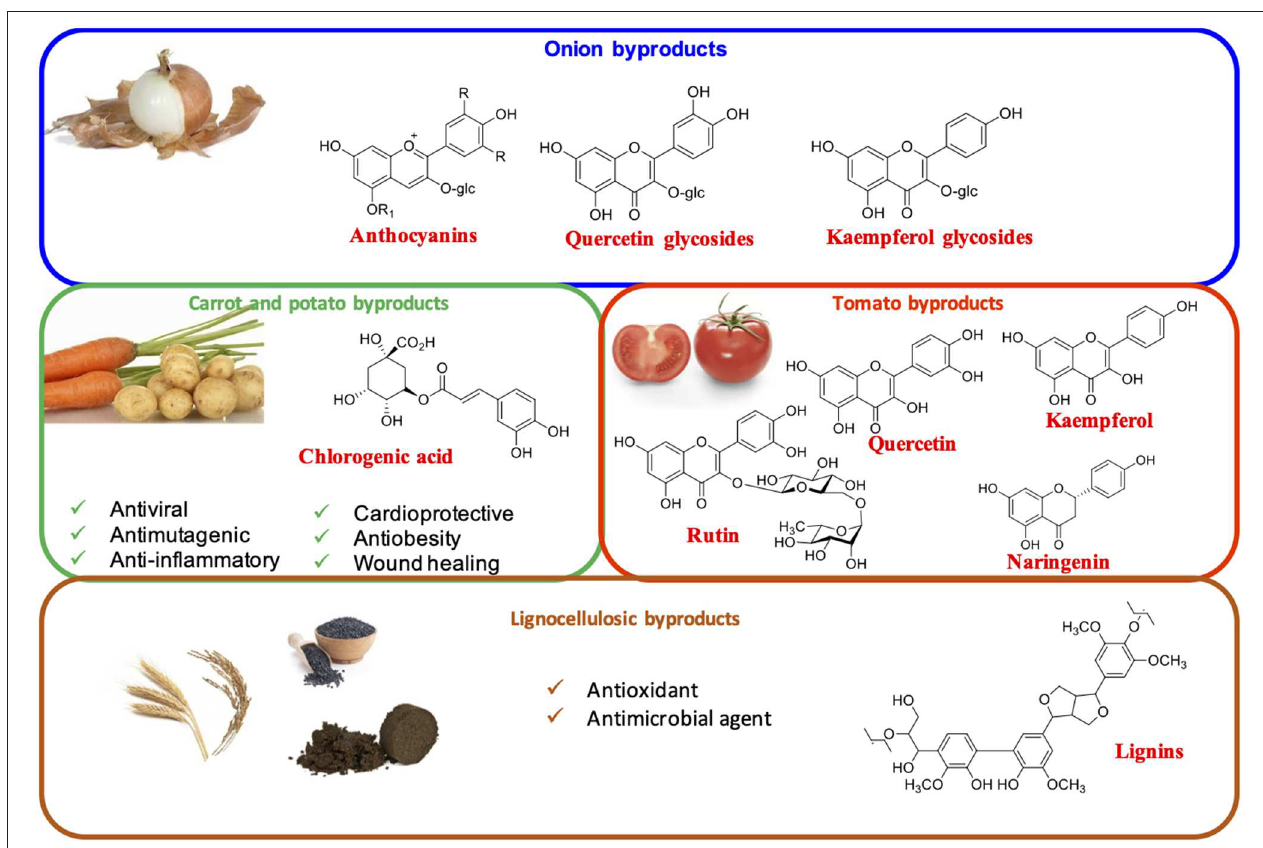
FIGURE 2 | Main vegetable and lignocellulosic byproducts. Shown are the most abundant phenolic components and the reported